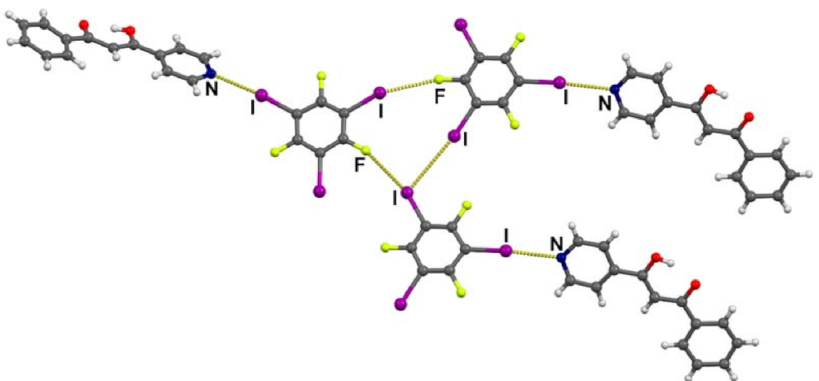
Figure 8. A fragment of a halogen bonded chain of ( b4pm )( 135tfib ) molecular complexes in the crystal structure of ( b4pm )( 135tfib ). Hydroxyl hydrogen atoms were located from the electron difference map.